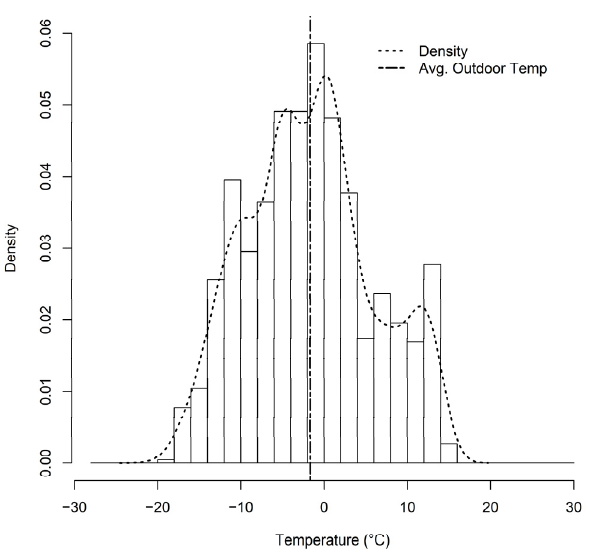
Figure 1. Outdoor air temperature histogram of one electric meter period.